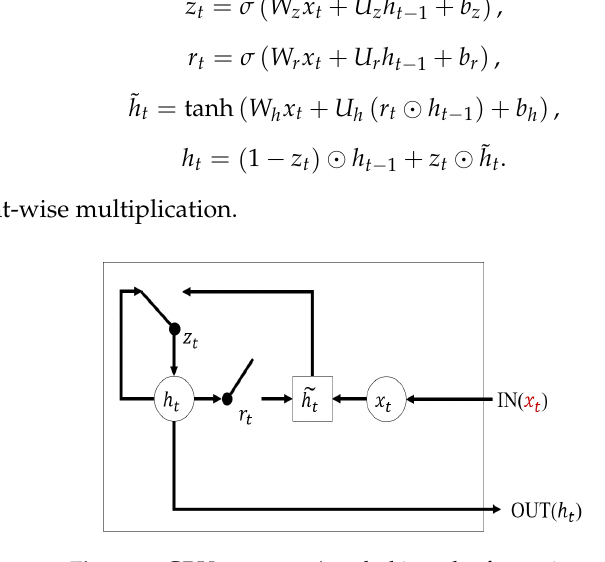
Figure 2. GRU structure (symbol in red refers to